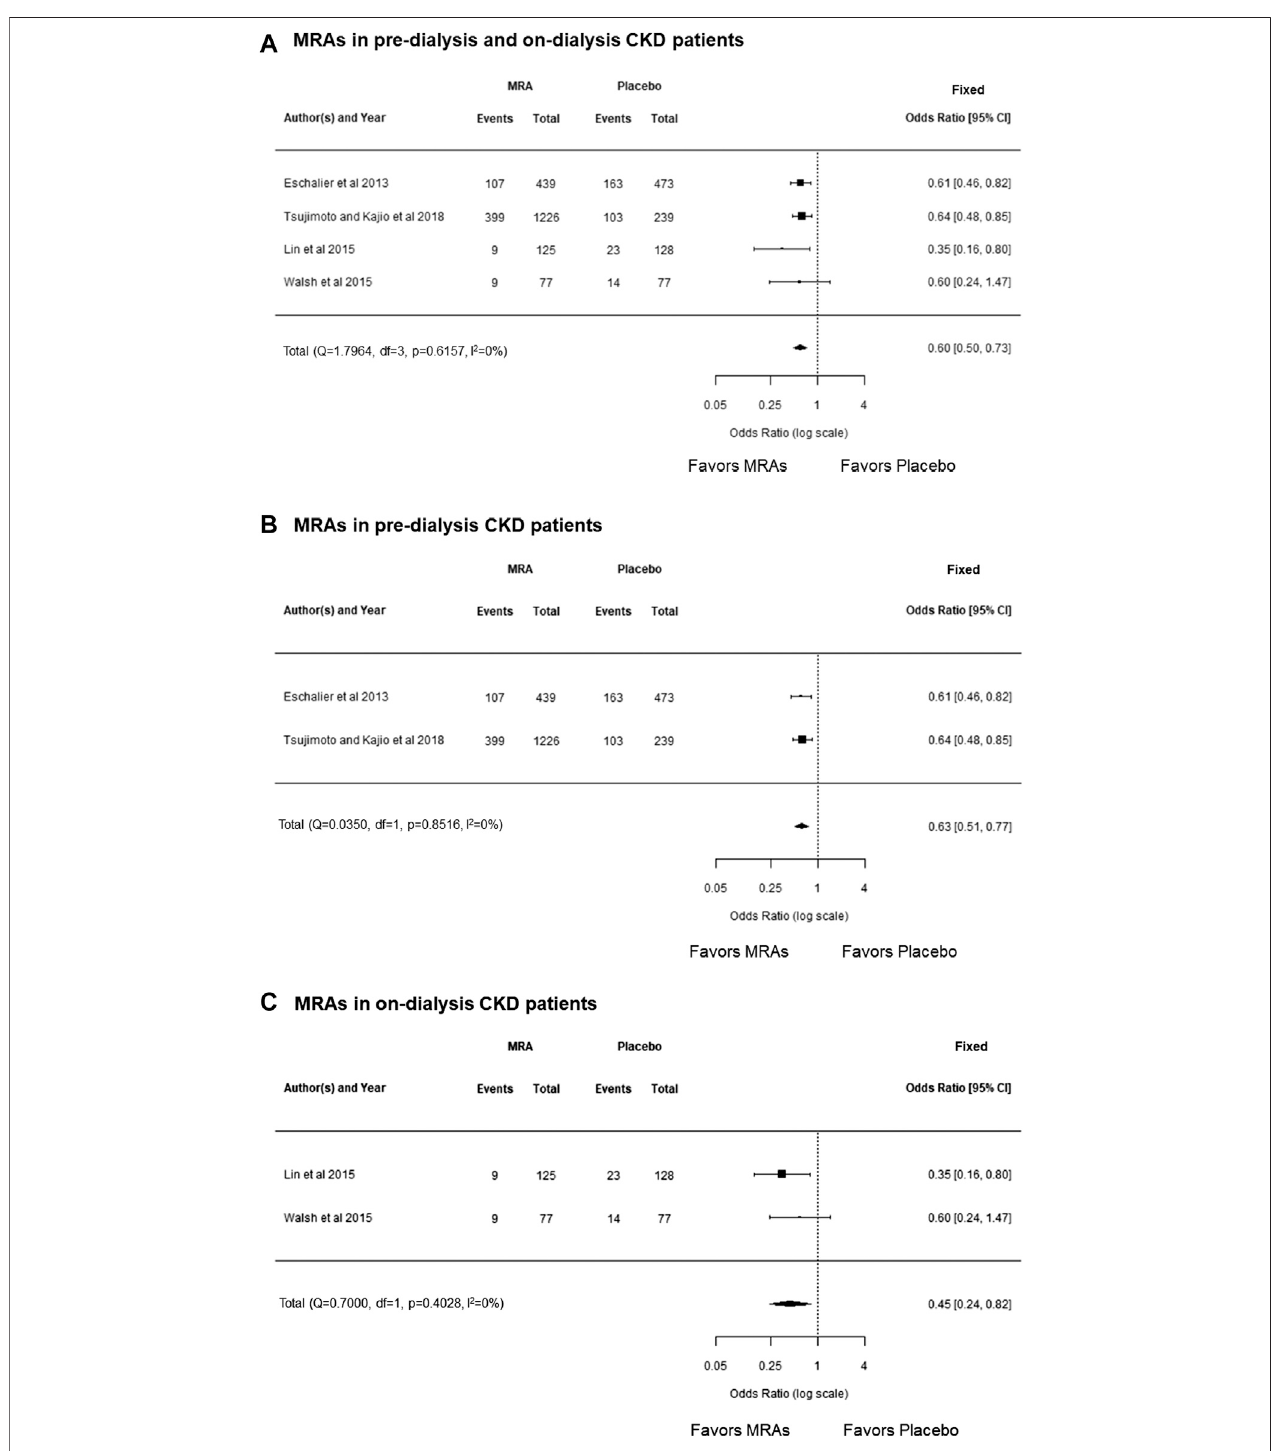
FIGURE 5 | (A) Forest plot describing a comparison of the incidence of cardiovascular events between MRAs and placebo in pre-dialysis and on-dialysis patients with CKD. (B) Forest plot describing a comparison of the incidence of cardiovascular events between MRAs and placebo in pre-dialysis patients with CKD. (C) Forest plot describing a comparison of the incidence of cardiovascular events between MRAs and placebo in on-dialysis patients with CKD. CI, con fi dence intervals; CKD, chronic kidney disease; MRAs, mineralocorticoid receptor antagonists.